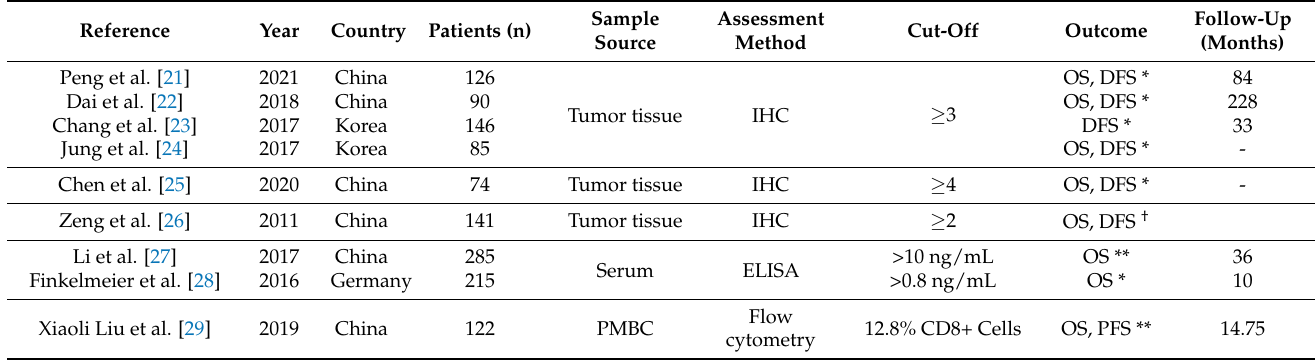
Table 1. Main characteristics of studies included in the meta-analysis.